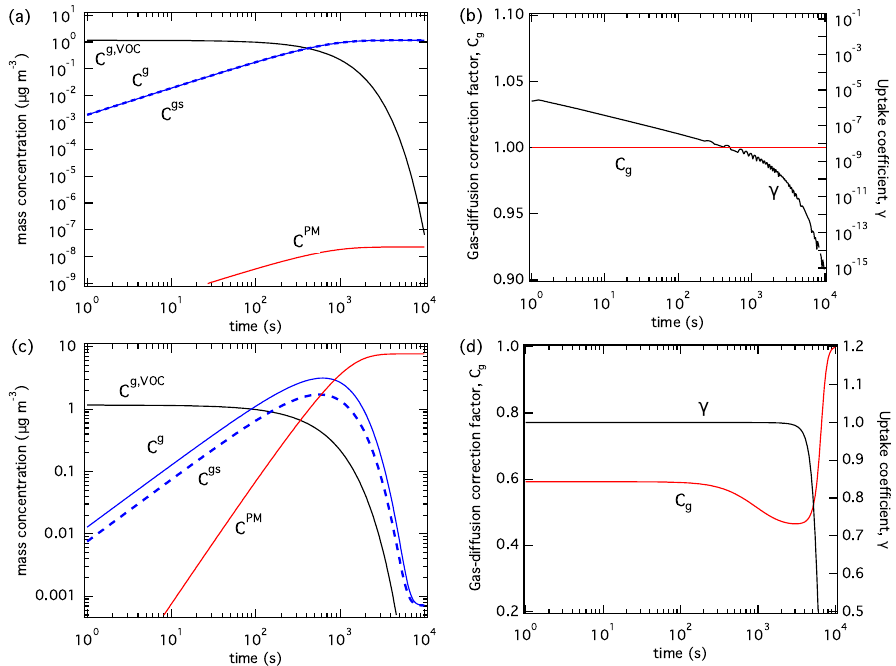
Figure 4. Temporal evolution of mass concentrations of the parent VOC in the gas phase ( C g,VOC , black), the hypothesised VOC oxidation product as in the gas phase ( C g , solid blue), in the near-surface gas phase ( C gs , dashed blue), and in the particle phase ( C PM , red) for MVK (a) and C 20 H 32 O 12 (c) . Temporal evolution of gas phase diffusion correction factor ( C g,diff , γ eff /γ , red curve) and uptake coefficient ( γ , black curve) for MVK (b) and C 20 H 32 O 12 (d)